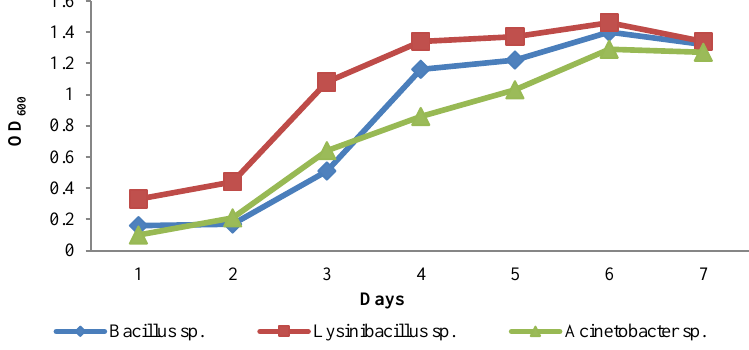
Fig. 1. Cell density (OD 600 ) of cultures of lignin-degrading gut isolates of Coptotermes curvignathus grown in LB medium supplemented with kraft lignin